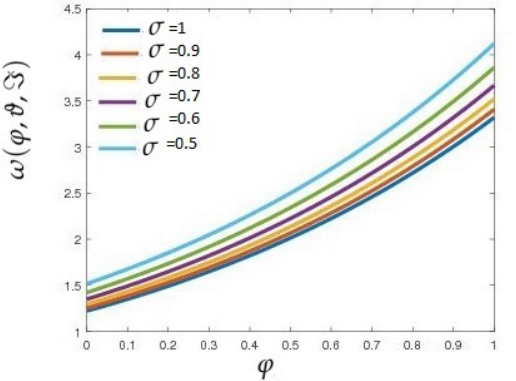
Figure 11. The approximate solution graphs of different fractional order of δ for µ ( ϕ , ϑ ) and ν ( ϕ , ϑ ) , Example 1.